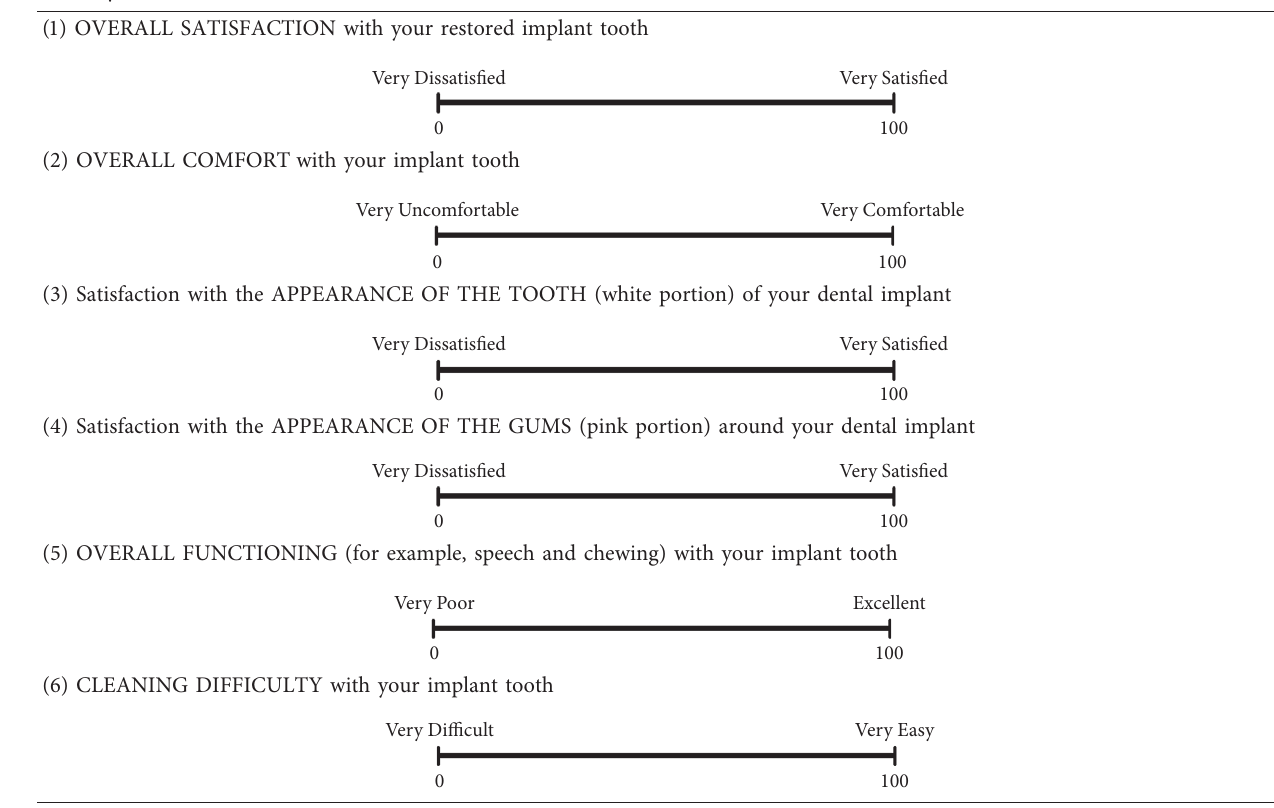
Table 3: The proposed standardized questionnaire used to subjectively assess patients’ self-perceptions of aesthetic outcomes in implant